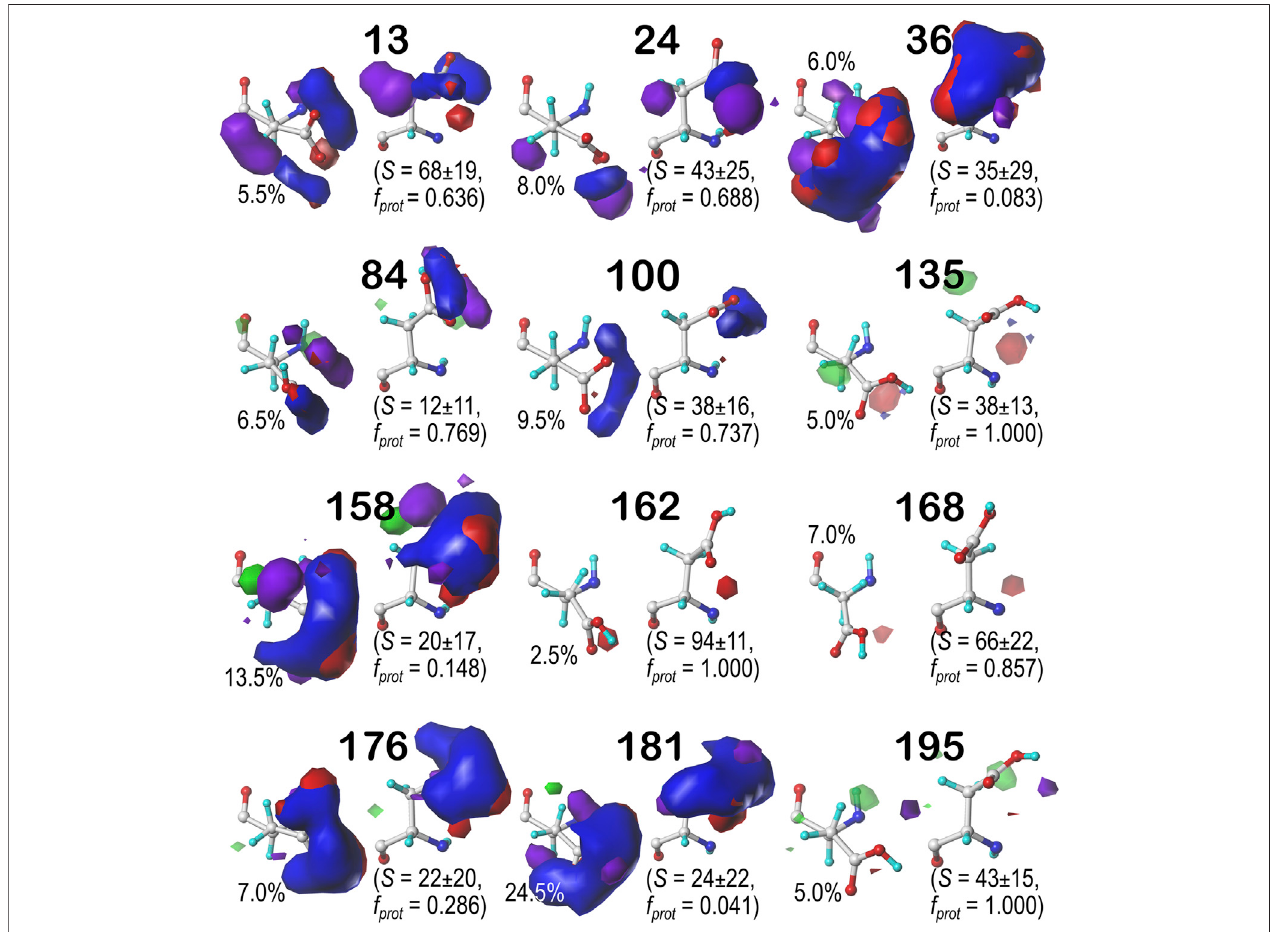
FIGURE9| HydropathicinteractionmapsdisplayingtheGaussian-weightedaveragesidechainenvironmentsofasparticacidinthe χ 1 (cid:1) 300 ° parseofthe b1 chess square at pH (cid:1) 3.345. See caption for Figure 7 .